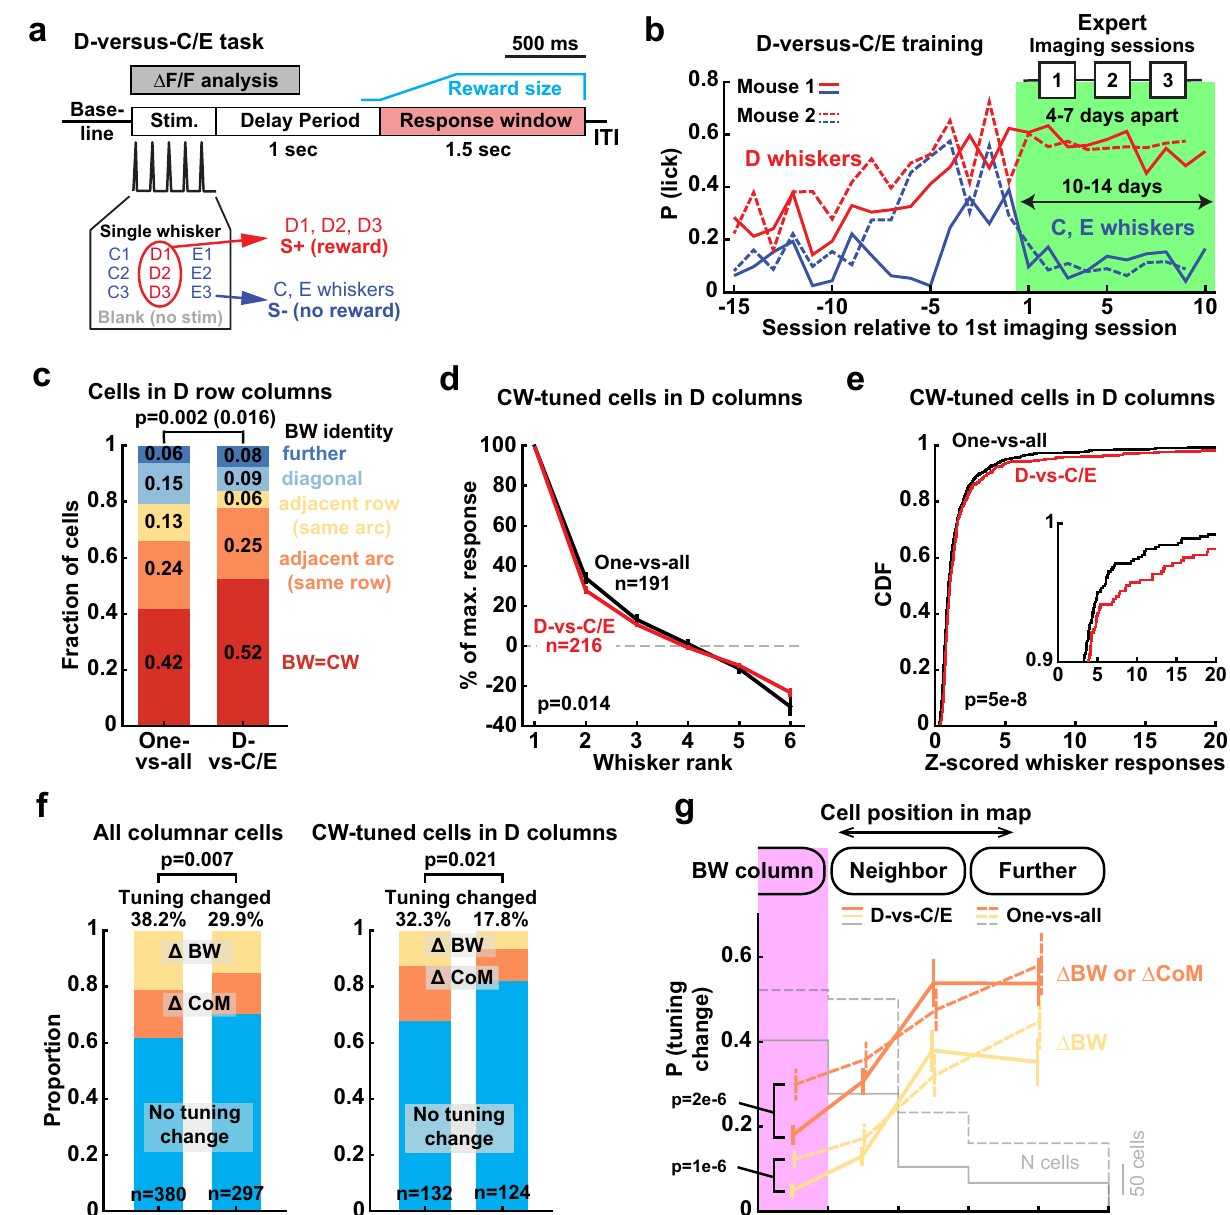
Fig. 8 | D-versus-C/E discrimination training reduces tuning instability, but only for CW-tuned neurons. a Trial structure and stimulus-reward contingencies for the D-versus-C/E whisker discrimination task. b Behavioral performance for 2 mice, during task learning (last 15 days before imaging) and during imaging ses- sions when mice were experts. c Tuning heterogeneity for cells in D-row columns, comparedbetweenone-versus-allmice( n =191cellsfrom4mice)andD-versus-C/E mice ( n =216 cells from 2 mice). Statistics: χ 2 for difference in distribution, and (in parentheses) Fisher ’ s exact test for proportion of CW-tuned cells, two-sided. d Mean rank-ordered whisker tuning curves for CW-tuned neurons in D whisker columns. p -value isfor task factor in unbalanced two-wayANOVA. Errorbars: SEM.